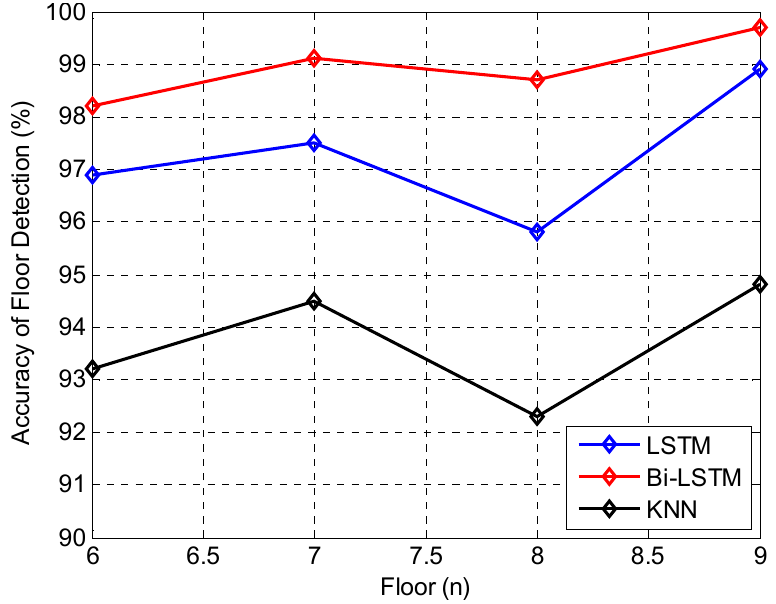
Figure 8. Precision Comparison of Floor Detection.